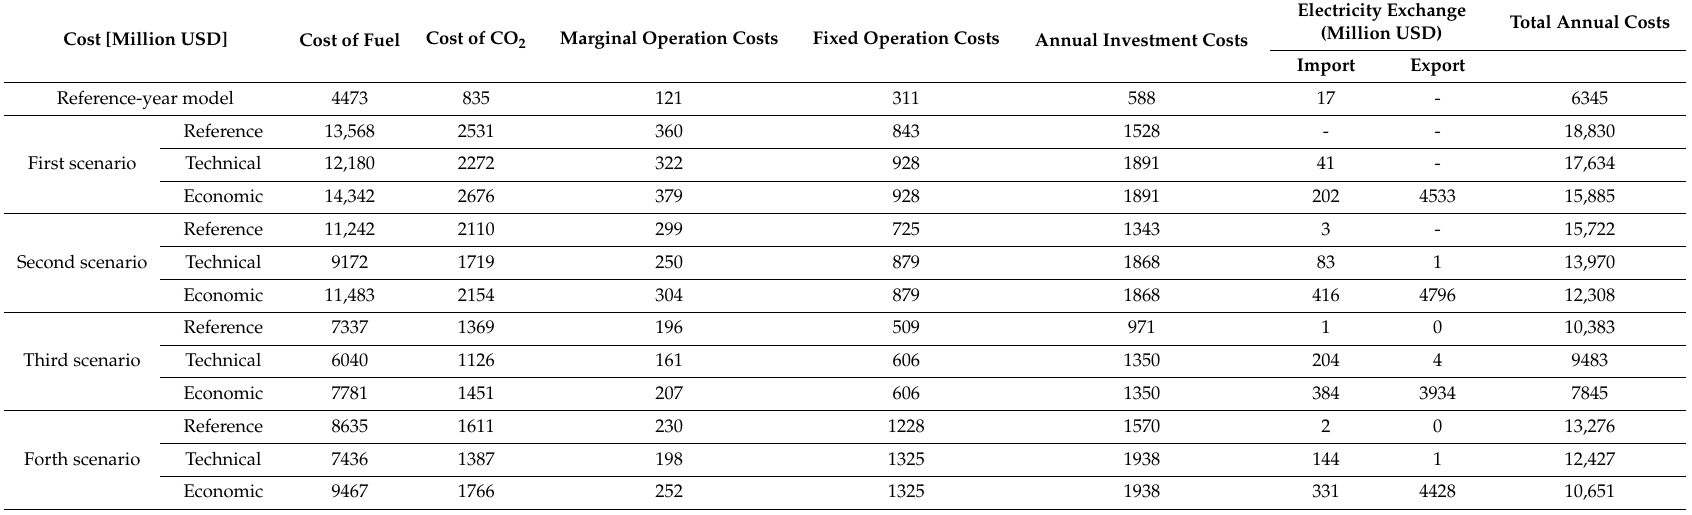
Table 13. Comparison of fuel, CO 2 emission, marginal and fixed operations, annual investment, electricity exchange, and total costs of the various scenarios discussed. Cost [Million